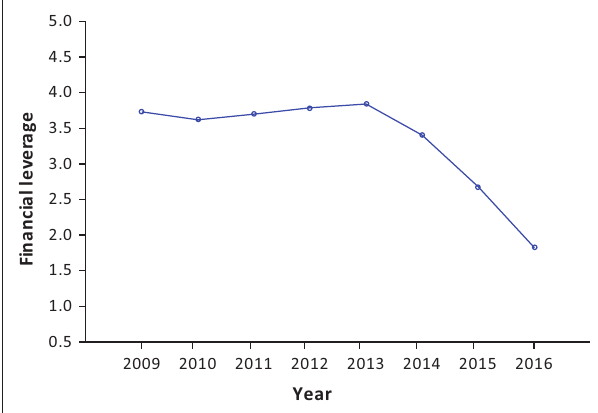
FIGURE 1: Fisher least significant difference results for financial